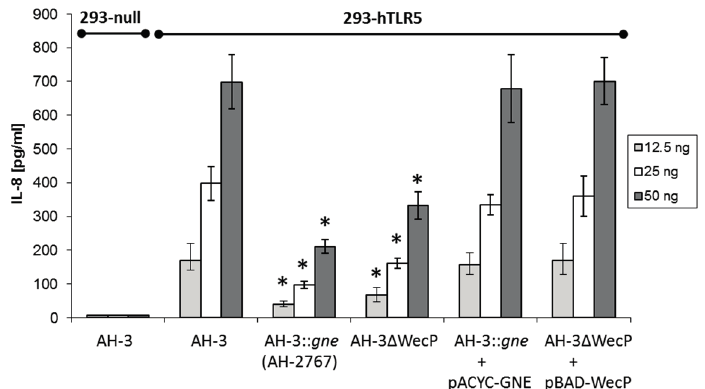
Figure 3. Human embryonic kidney cells (HEK293-null) and cells stably transfected with the human toll receptor 5 (TLR5)-gene ( HEK293-hTLR5 ) were exposed to three